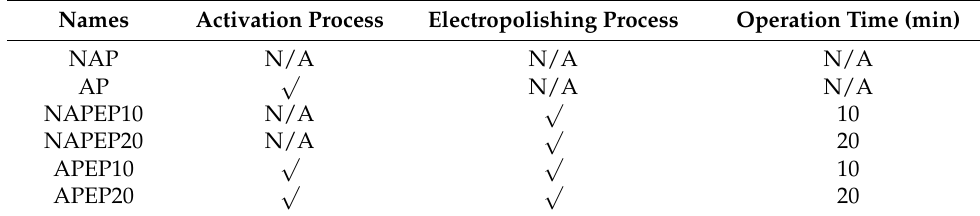
Table 1. The names of the samples in this